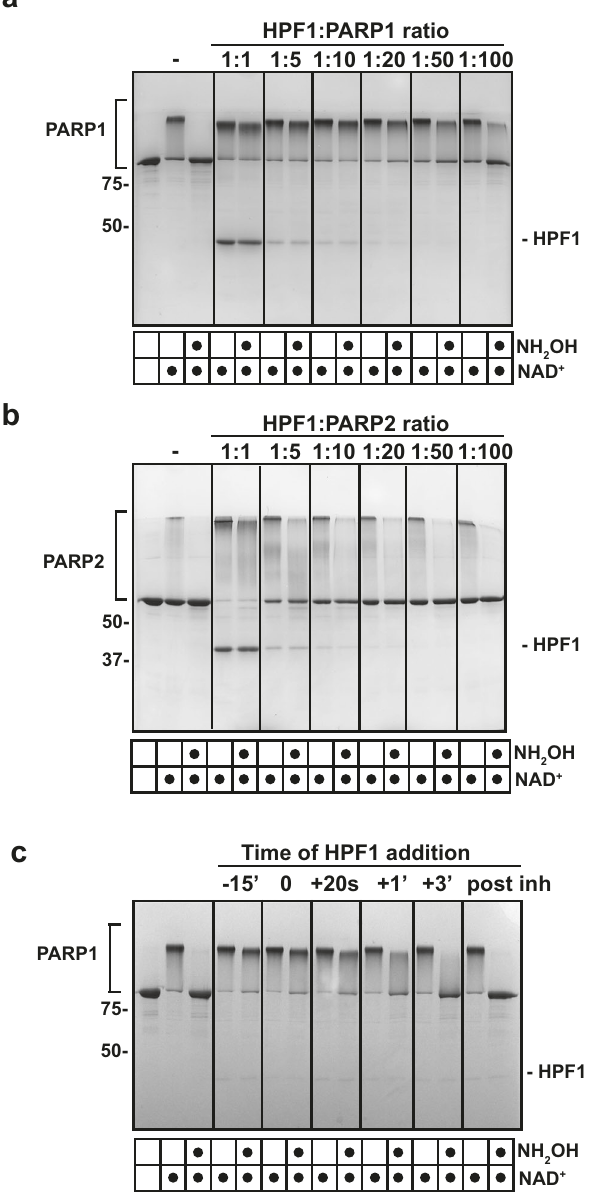
Fig. 2 HPF1 works ef fi ciently at sub-stochiometric ratios relative to PARP1 and PARP2. a PARP1 (1 μ M) or b PARP2 (1 μ M) was incubated